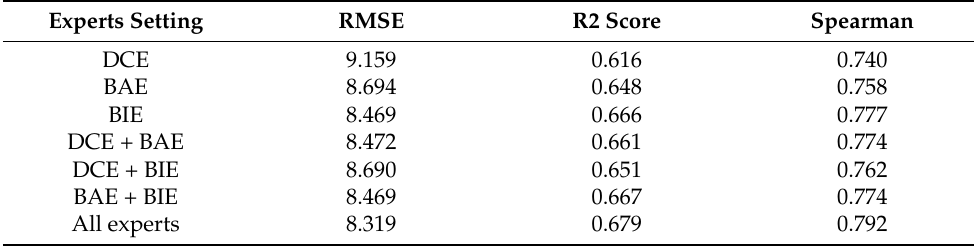
Table 2. The expert ablation experiment